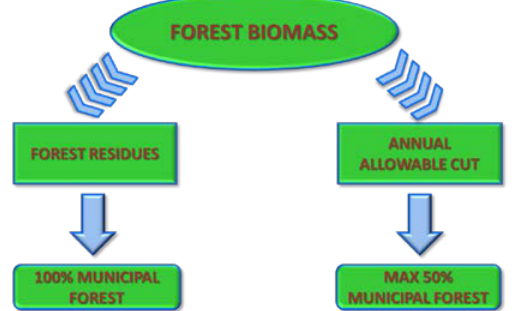
Figure 3. Characterization of bio-energetic supply. Source: elaboration of the